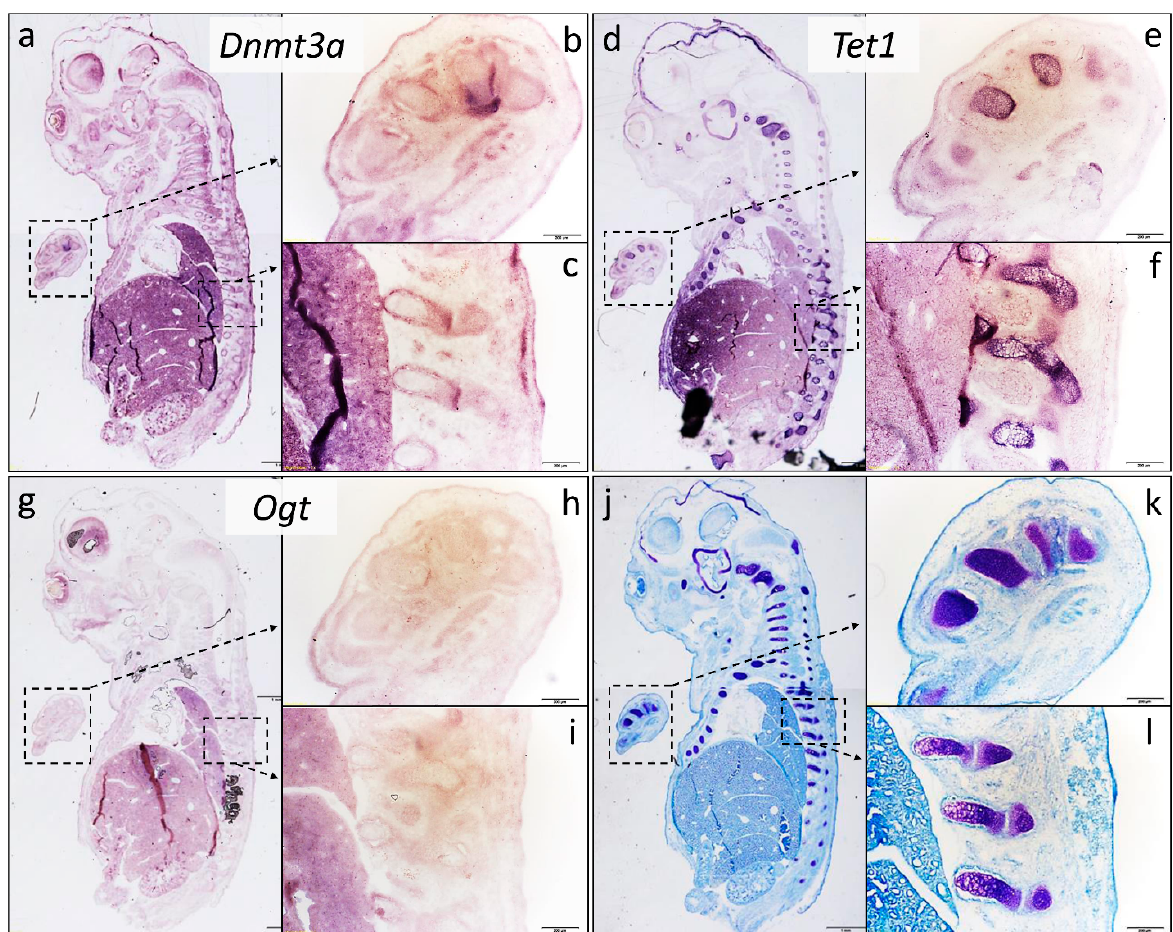
Figure 4. In situ hybridization analysis of epigenetic-associated gene expression in E15 whole mouse embryos. Sagittal sections of frozen embryos were processed with RNA probes encoding Dnmt3a ( a – c ), Tet1 ( d – f ), and Ogt ( g – i ). Sections were also stained with DMMB for cartilage-specific proteoglycans ( j – l ). Metachromatic (purple) areas in photomicrographs show polyanionic glycosaminoglycan-rich cartilage ECM. Photomicrographs of sections from whole embryos were taken with a 4× objective ( a , d , g , j ). Inserts were taken with a 10× objective, which correspond to areas indicated with boxes ( b , c , e , f , h – k ). Note the strong expression of Dnmt3a and Tet1 in maturing chondrocytes of the developing vertebrae and limb buds in the mouse embryo. Scale bar for ( a , d , g , j ): 1 mm, for the rest: 200 μ m.